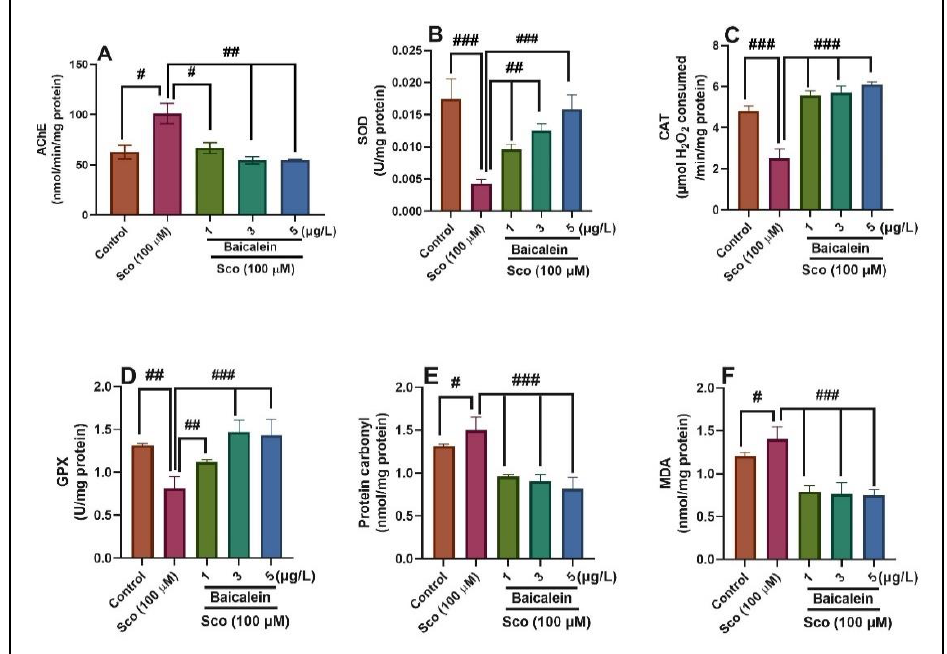
Figure 4. Effects of the baicalein 5,6-dimethyl ether on ( A ) AChE; ( B ) superoxide dismutase (SOD); ( C ) catalase (CAT) and ( D ) glutathione peroxidase (GPX) specific activities; ( E ) protein carbonyl and ( F ) malondialdehyde (MDA) levels. Values represent means ± S.E.M. ( n = 10) followed by Tukey’s post hoc analyses: ( A ) # p < 0.01 and ## p < 0.001; ( B ) ### p < 0.0001 and ## p < 0.001; ( C ) ### p < 0.0001; ( D ) ## p < 0.001 and ### p < 0.0001; ( E ) # p < 0.01 and ### p < 0.0001; ( F ) # p < 0.01 and ### p < 0.0001.